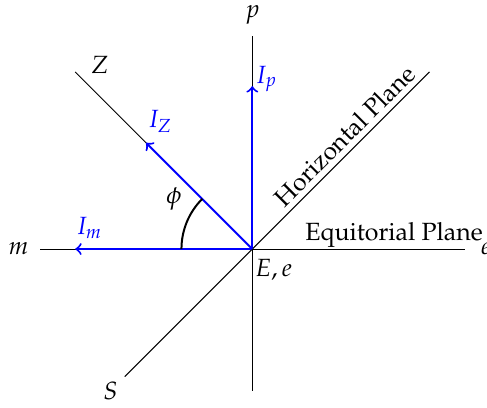
Figure 6. Vector diagram ( 2 D ) of a merged coordinate system.